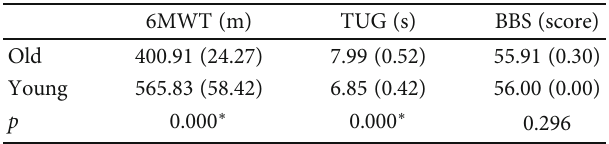
Table 4: Comparison of the results of functional evaluation between young and old healthy